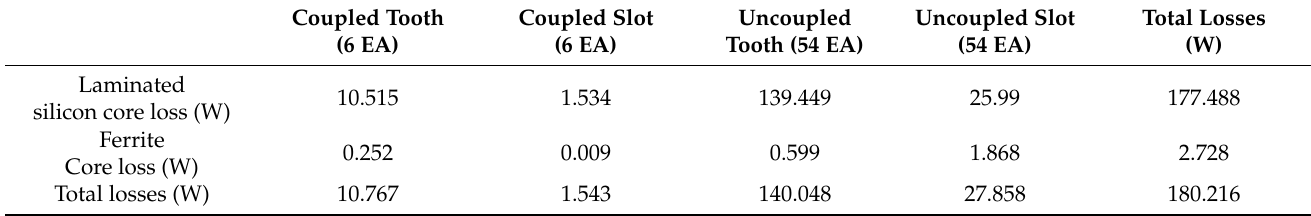
Table 4. Core losses with load.